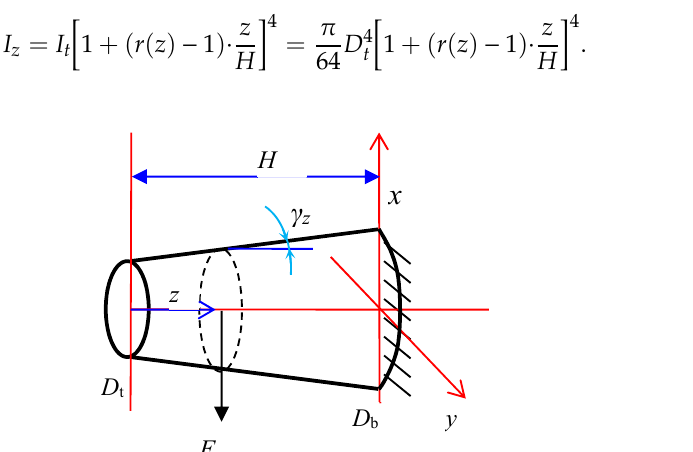
Figure 9. Schematic of a tapered rod defining the parameters for calculating its bending stiffness.